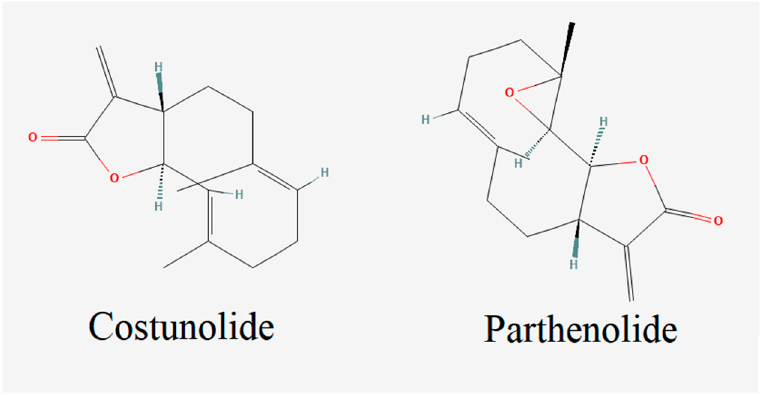
Figure 1. Chemical structures of costunolide and parthenolide terpenes.